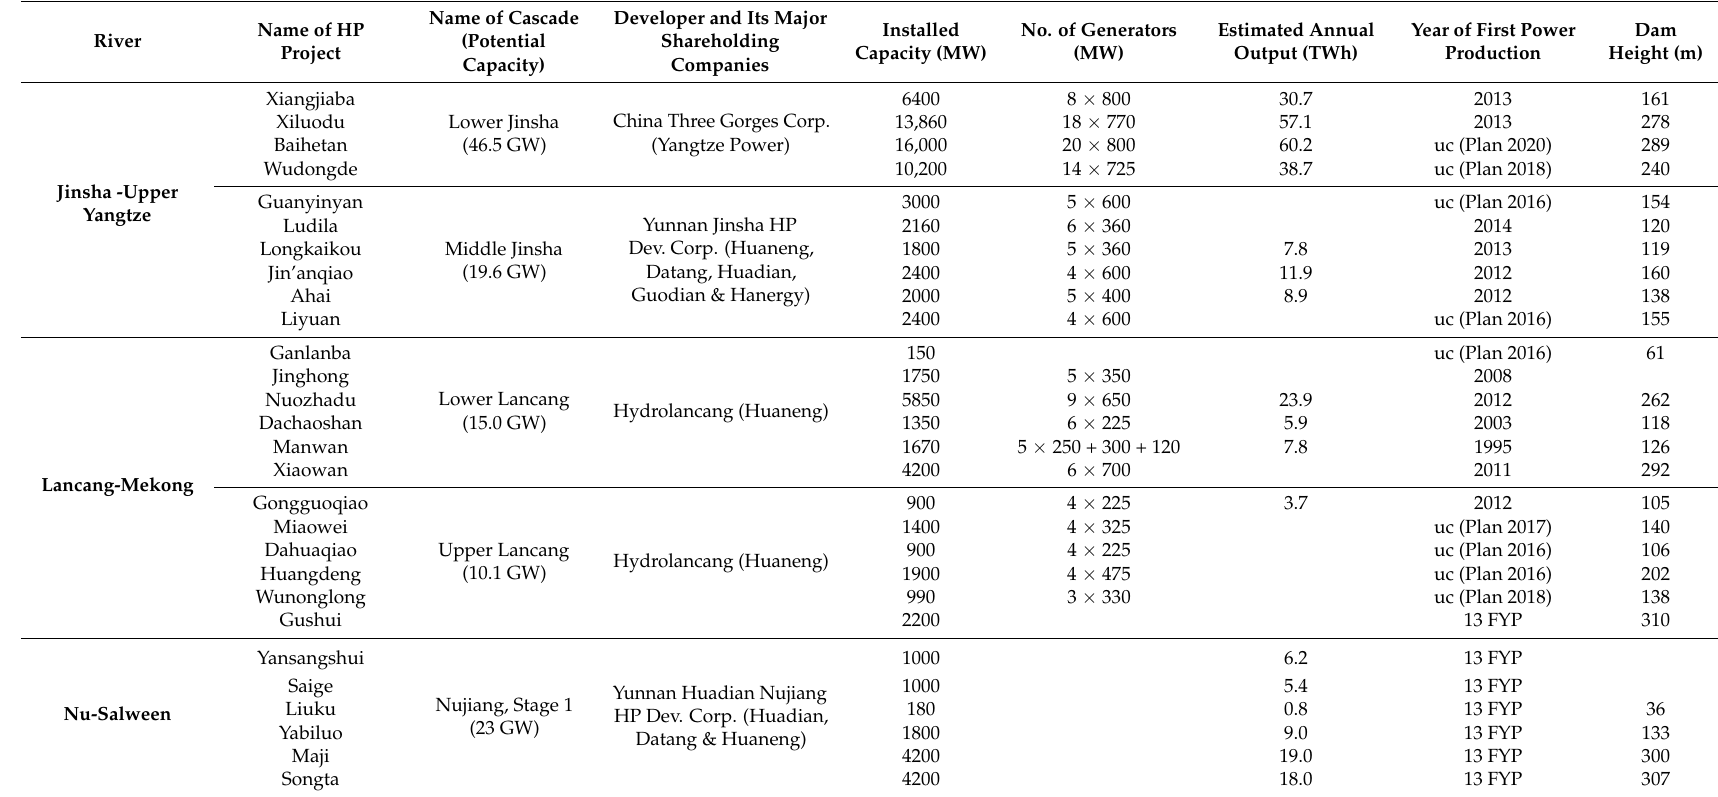
Table 1. Brief overview of hydropower stations along Yunnan’s three largest